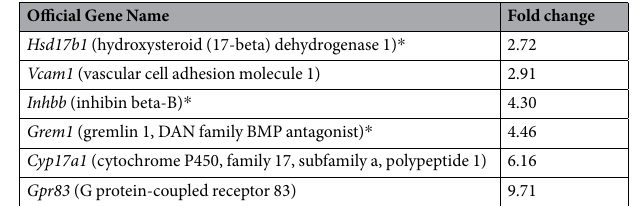
Table 2. A list of selected up-regulated genes in gcRunx2;CbfbKO mice. * , genes which were previously identified to be differentially regulated in cultured granulosa cells isolated from Cbfb flox/flox ;Cyp19 cre mice compared to those from wild-type mice 9 . Fold changes were calculated by comparing the average values for mutant mouse samples vs. littermate control mouse samples ( gcRunx2;CbfbKO /Wild-type). Lower expression in mutant mouse samples is given as − 2 rather than 0.5. The genes verified by qPCR were highlighted in green and red in Table 1 and Table 2,